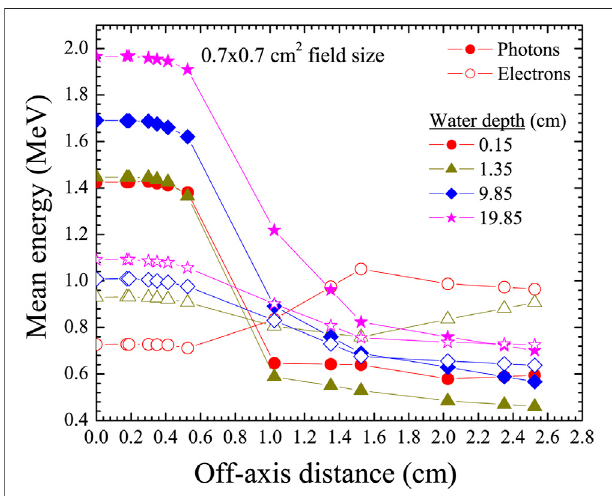
Frontiers in Physics |